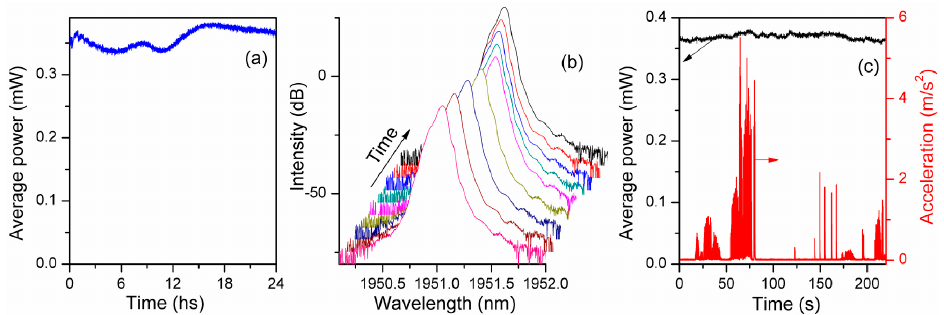
Figure 4. ( a , b ) Measured output power and spectrum, respectively, in 24 h operation. ( c ) Measured output power in a simulated harsh environment and acceleration modulus; (left and right ordinates, respectively).